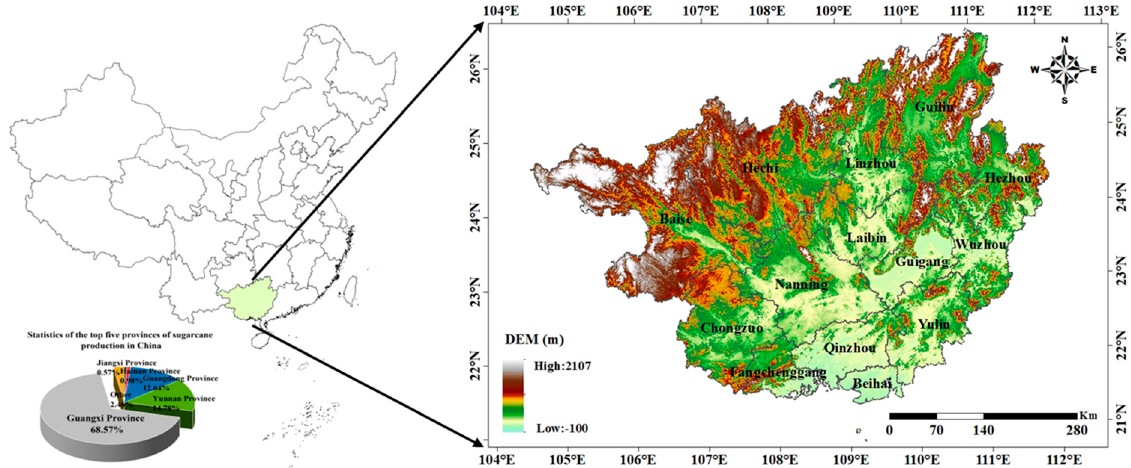
Figure 1. Location map and digital elevation model (DEM) of Guangxi Province. Table 1. Information on the data types and data sources used in the